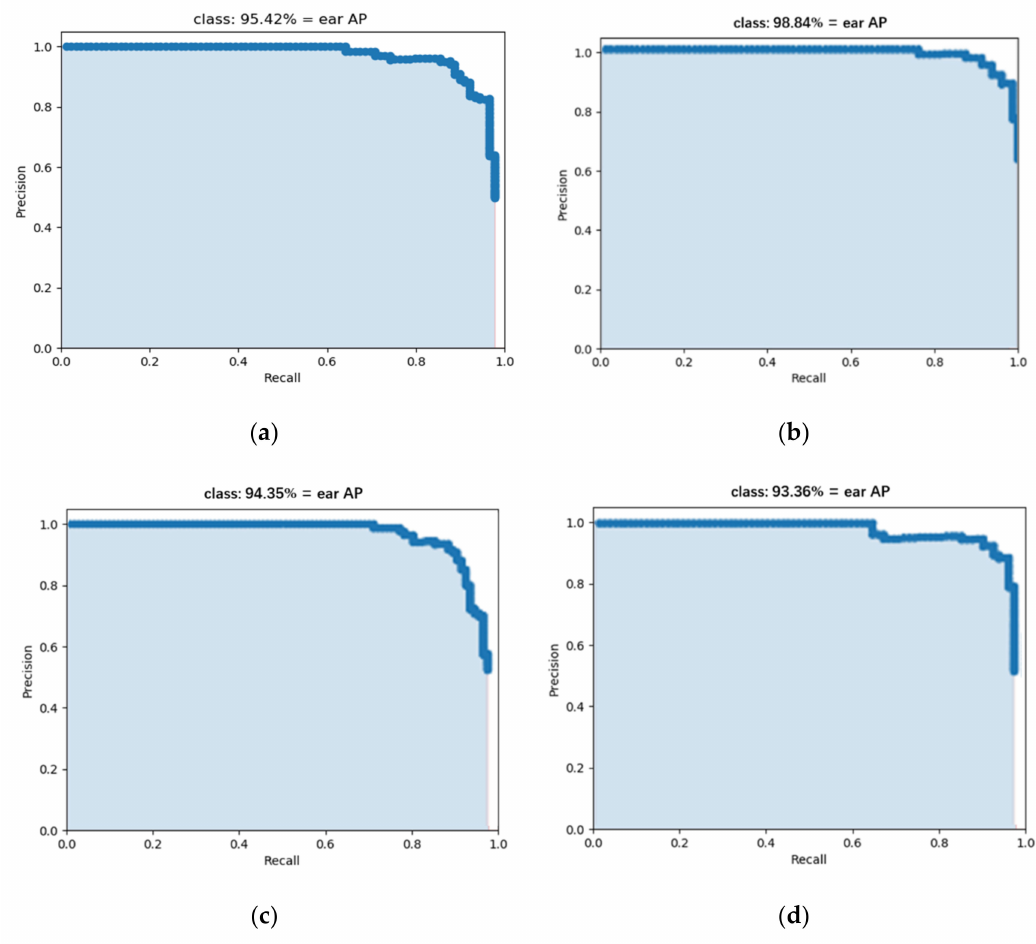
Figure 10. The recall rate and AP of the model on the test set, with no infection rice images ( a ); mild infection rice images set ( b ); moderate infection rice images set ( c ); and severe infection rice images ( d